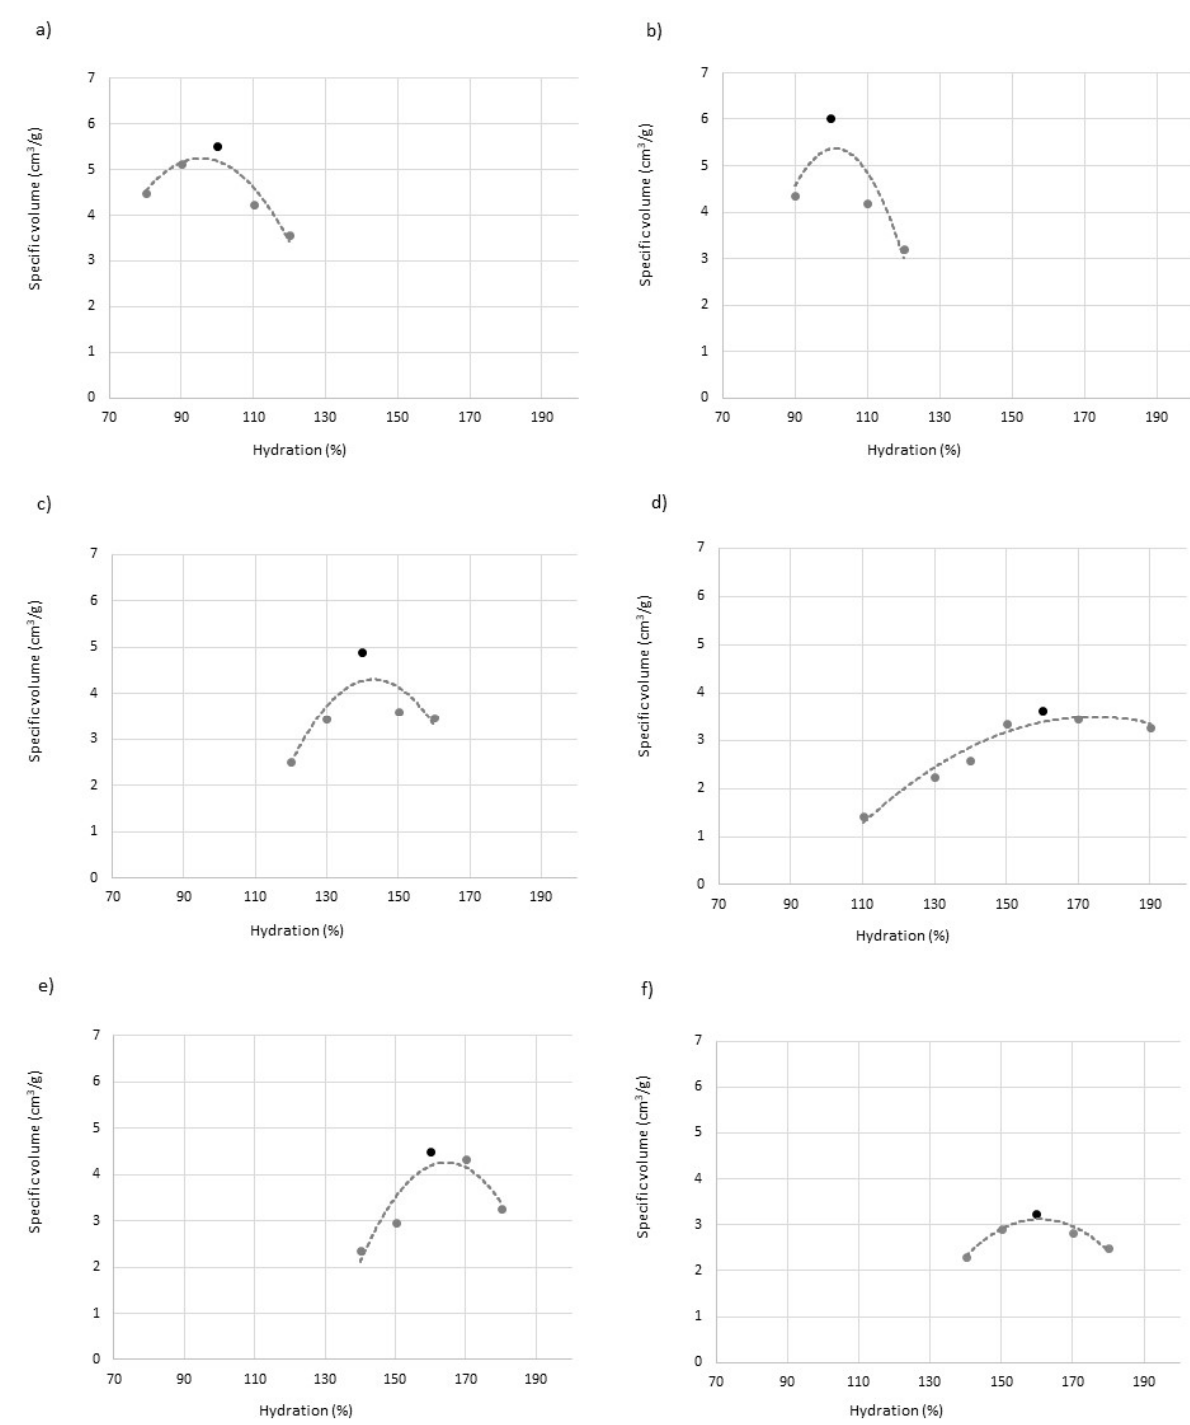
Figure 1. Hydration versus specific volume of gluten-free breads. Control 1 ( a ); Control 2 ( b ); CF 1 ( c ); CF 2 ( d ); ACF 1 ( e ); ACF 2 ( f ). Black dots indicate selected optimal hydration. CF: Citrus Fiber; ACF: Active Citrus Fiber. 1: Starch-based formula; 2: Flour and starch-based Table 1. Formulation (in grams) of bread samples prior to the determination of their optimum mois- ture content.